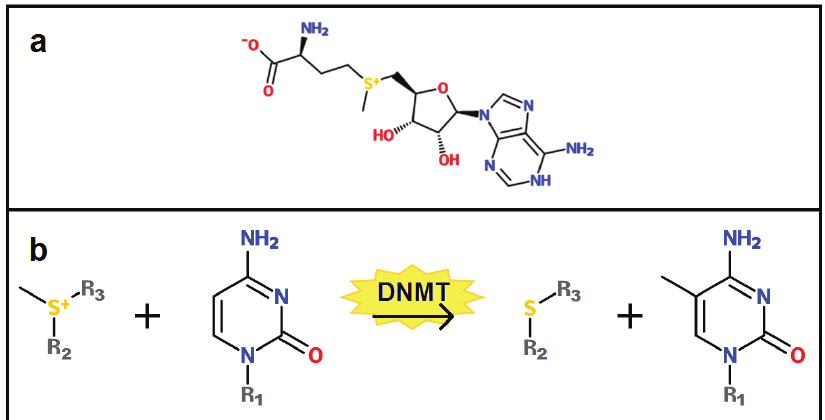
Figure 1. ( a ) The chemical structure of S-adenosyl methionine (SAM), which functions as a methyl donor during the methylation of a cysteine residue. ( b ) During DNA methylation, a DNA methyltransferase (DNMT1, DNMT3a or DNMT3b) catalyzes the transfer of a methyl residue from the sulfur atom of SAM to the 5-carbon atom of a cytosine base. In the figure, R1 represents the rest of the DNA molecule to which the cytosine is attached, and R2 and R3 represent the rest of